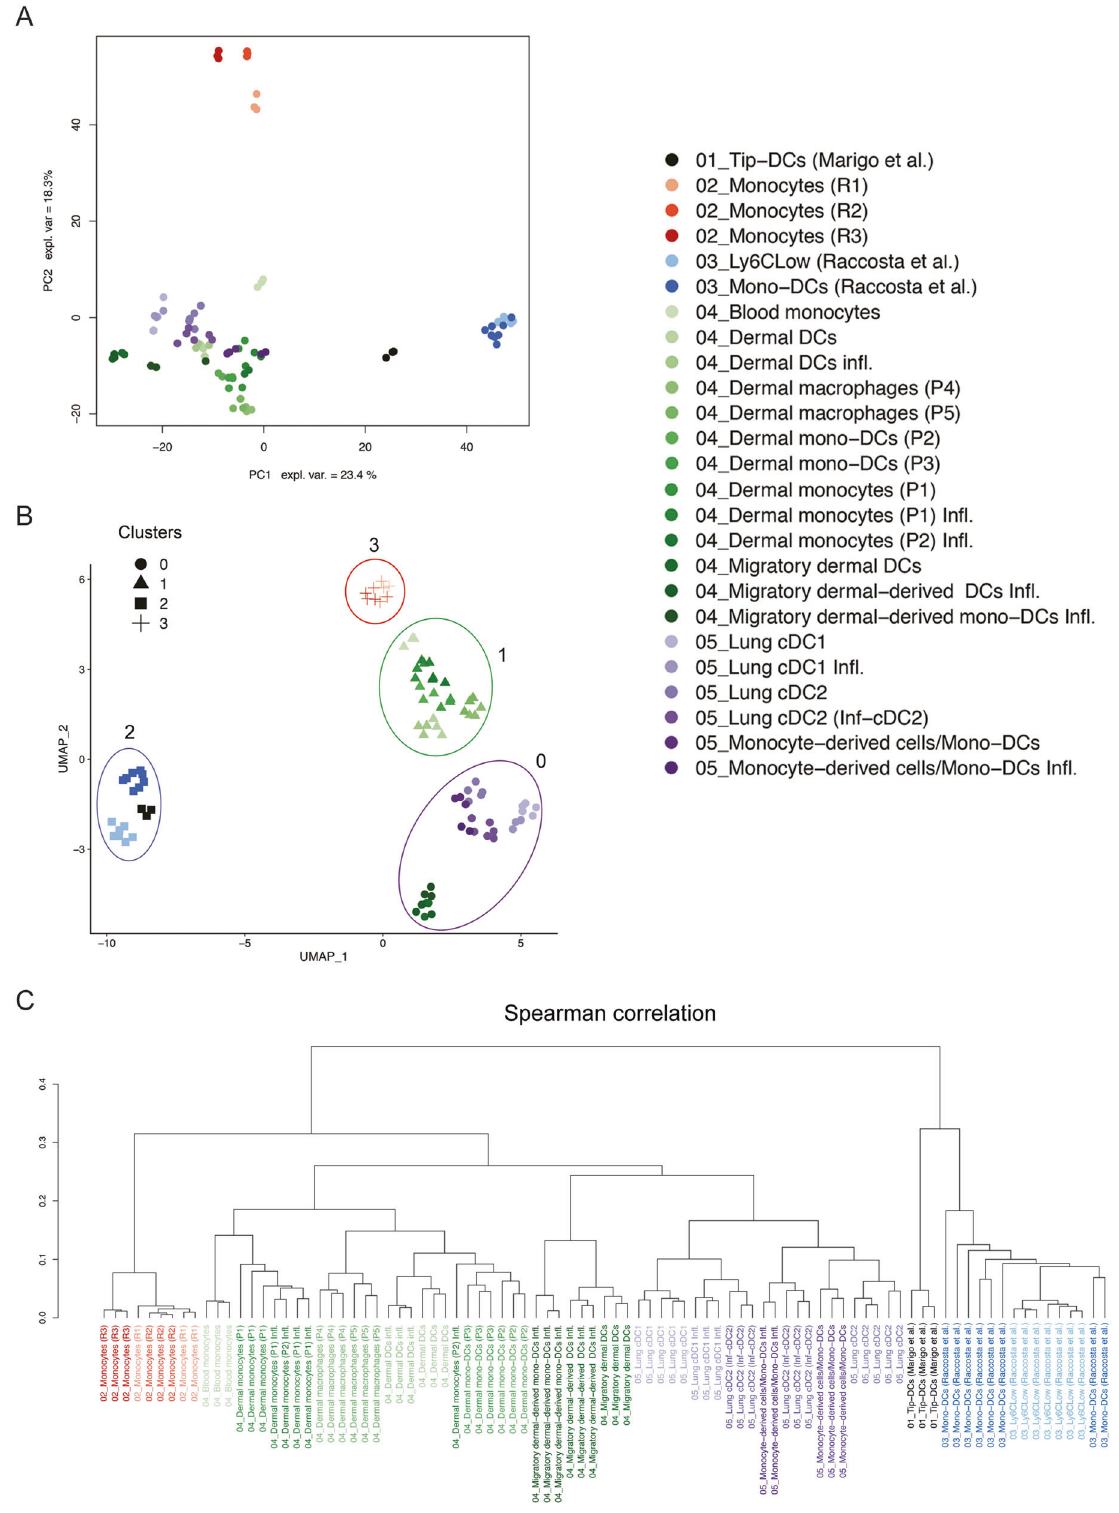
Fig. 3 Transcriptomic features of monocyte-derived cells under SULT2B1b perturbation. A Principal Component Analysis (PCA) of the transcriptomes of mono-DCs and Ly6C low cells isolated from LLC-Mock and LLC-SULT2B1b tumors, integrated with 4 datasets present in the GEO (Gene Expression Omnibus) Database. PCA based on the expression values of 10080 genes detected in all the fi ve experimental datasets. The fi rst two principal components are shown (PC1 accounted for 23.4 % and PC2 for 18.3% of the variance among samples). B Uniform Manifold Approximation and Projection analysis (UMAP) of the transcriptomes as reported in ( A ). The fi gure shows bidimensional UMAP representation of the integrated dataset. Four different clusters have been identi fi ed using graph-based techniques. C Hierarchical clustering analysis. Hierarchical clustering of the expression values of 10080 genes detected with average linkage was performed on the speci fi ed subsets to assess their transcriptional relatedness. Spearman correlation-based distance was